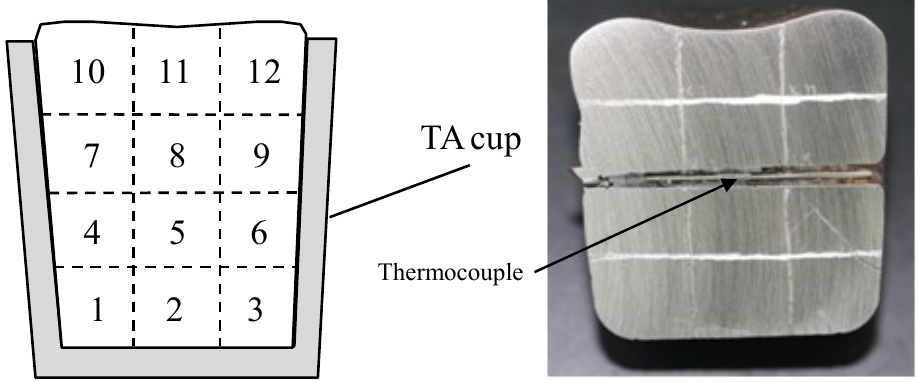
Figure 1. Fields distribution of thermal analysis (TA) samples made for metallographic